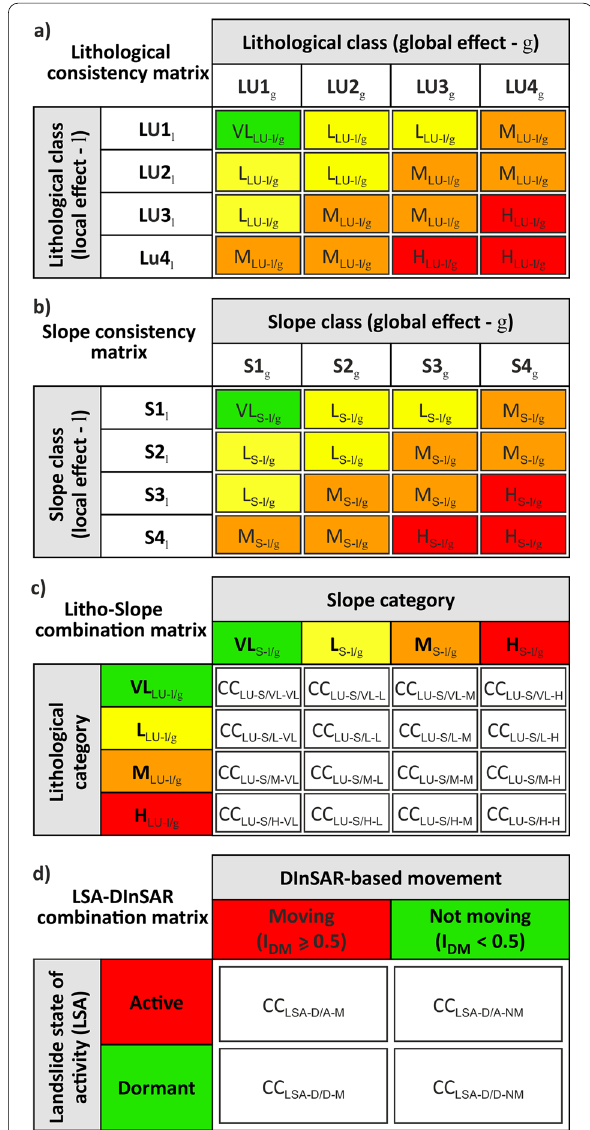
Fig. 3 Matrices used in the second- and third-phase of analysis to evaluate the Equivalent Vulnerable Area (EVA): a Lithological consistency matrix with the considered qualitative indicators (VL LU Very low; L LU low; M LU Medium; H LU High); b Slope = = = = consistency matrix with the considered qualitative indicators (VL S Very low; L S low; M S Medium; H S High); c Litho-Slope = = = = combination matrix with Litho-Slope Correction Coefficients (CC LU-S ); d LSA-DInSAR combination matrix with the LSA-DInSAR Correction Coefficients